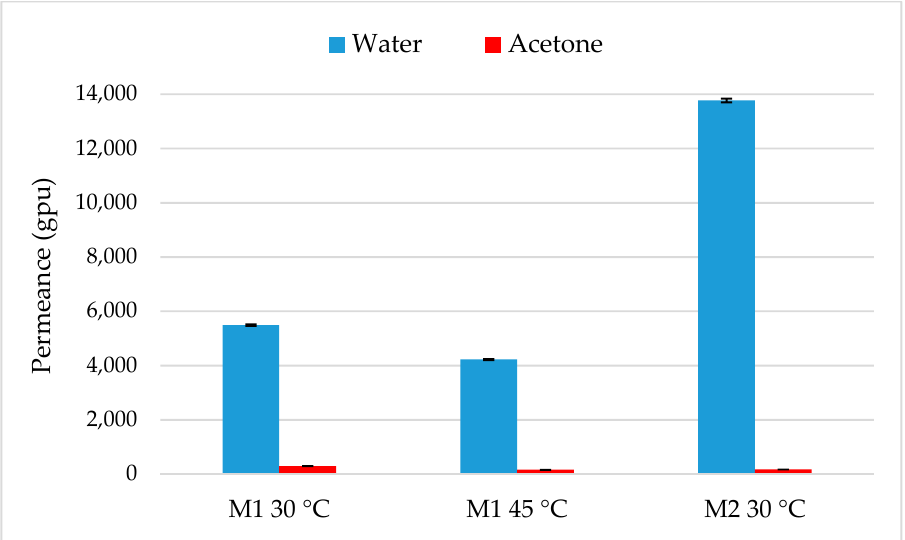
Figure 7. Permeance values for water and acetone depending on temperature and membrane. Membranes 2019 , 9 , x FOR PEER REVIEW